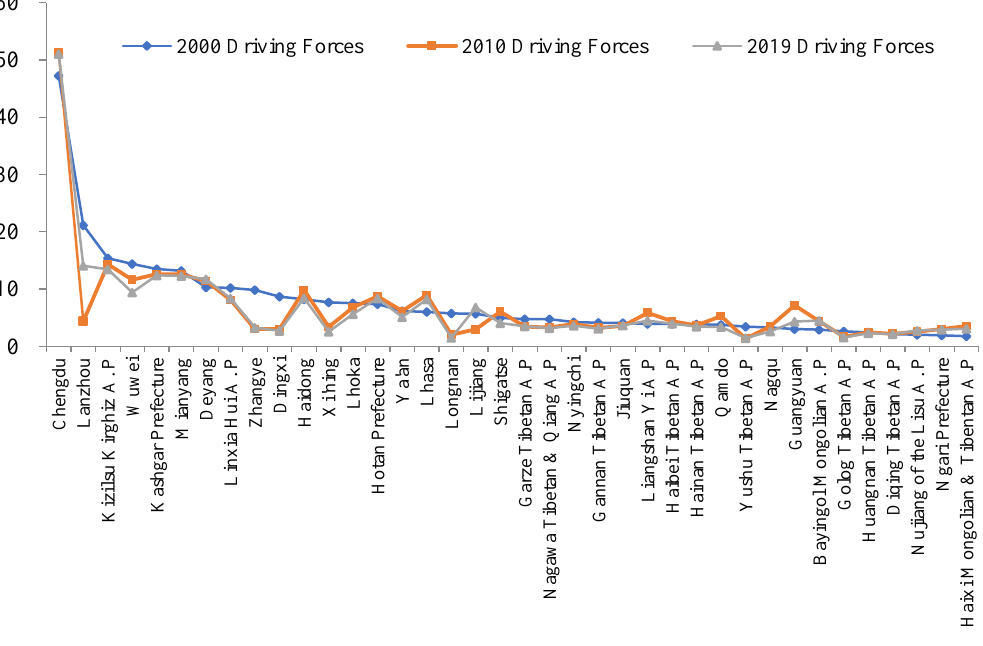
Figure 6. Economic Security Index and its Fractal Dimension Indexes of Prefecture-level Cities in the Qinghai–Tibet Plateau.